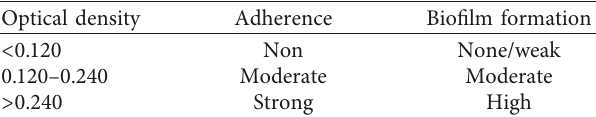
Table 2: Classification of bacteria adherence by the M.T.P method [28].